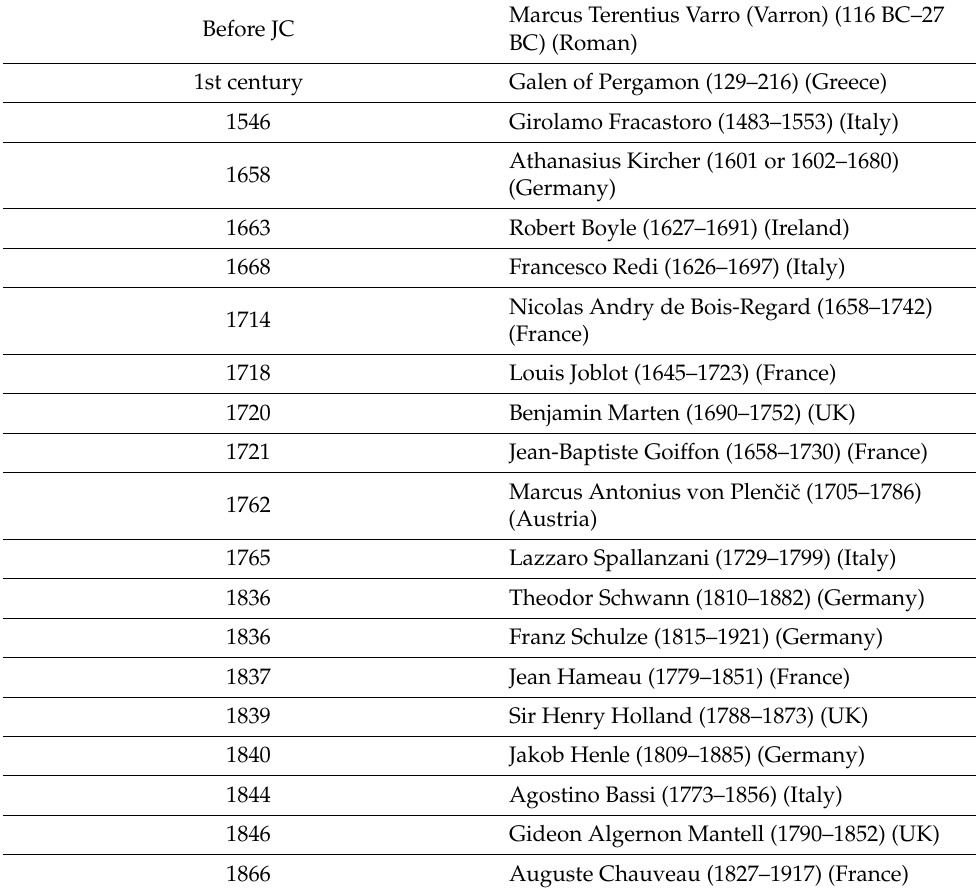
Table 3. Some of the precursors who, before Louis Pasteur, proposed the germ theory and/or refuted the concept of spontaneous